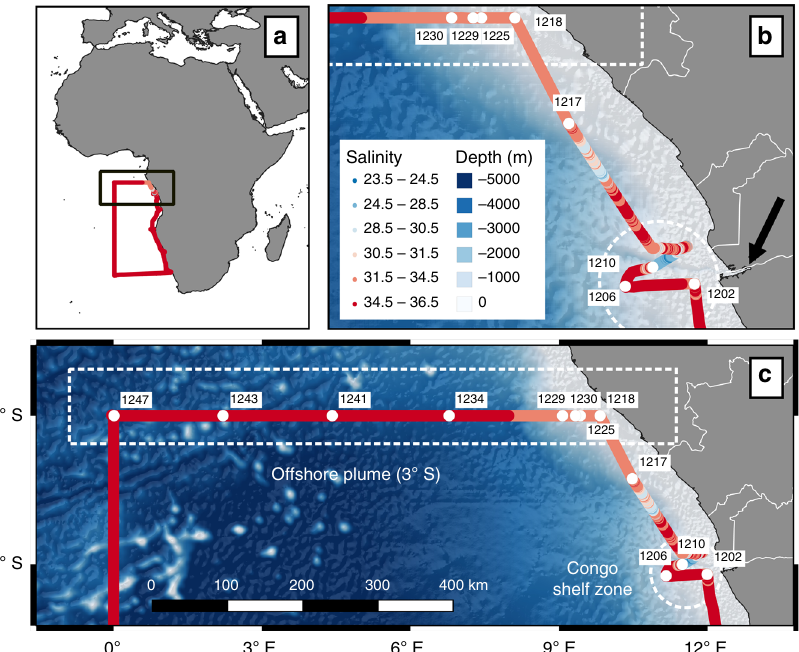
Fig. 1 Map of the study region showing station locations along the GEOTRACES GA08 cruise transect. Ship underway salinity measurements along the cruise section ( a ). Insets provide a detailed view of the study region including bathymetry and 228 Ra stations sampled in the Congo-shelf-zone ( b ; stations 1202, 1206, and 1210), along the coastal transect (between stations 1210 and 1218), and along the offshore 3°S transect ( c ; stations 1218 – 1247). Satellite- derived surface seawater salinity during GEOTRACES cruise GA08 is provided in the Supplementary Information. Bathymetry and shoreline data were obtained from ref. 65 and ref. 66